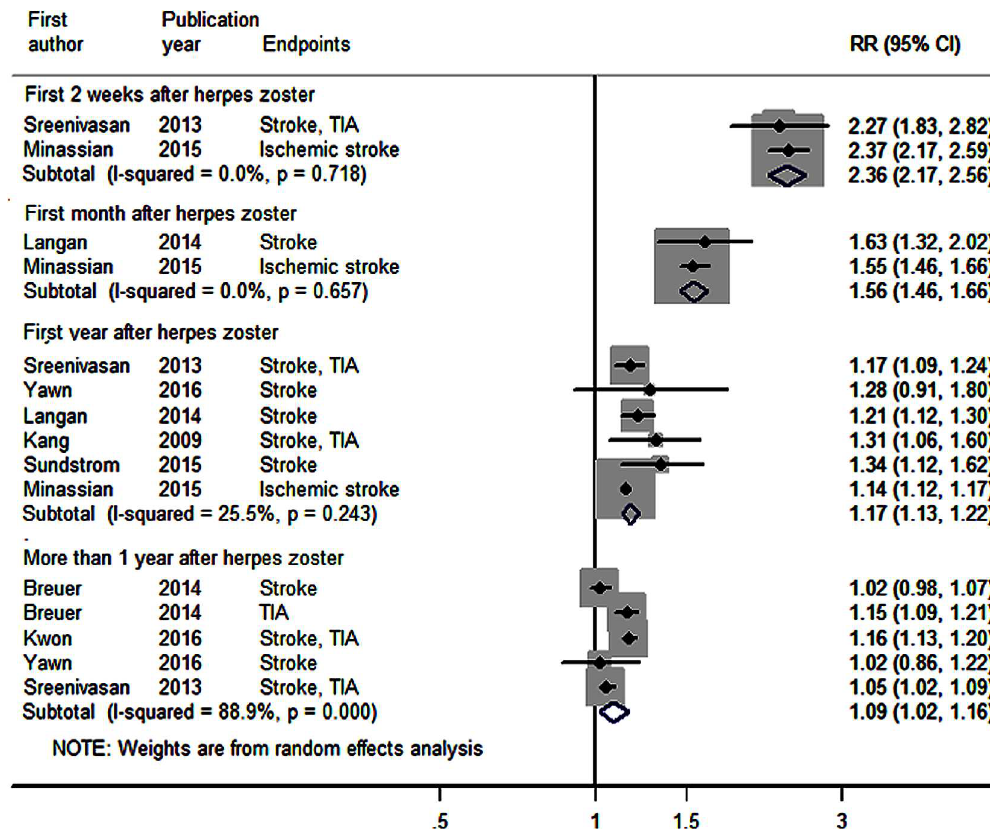
Fig 2. Forest plot of the association between herpes zoster and stroke. The figure shows meta-analysisof the stroke risks after herpes zoster for first 2 weeks, first month, first year, and more than 1 year, respectively. Diamondindicatesthe overall relative risks (RRs) for the analysis, width of the diamond represents the 95% confidence interval (CI), and boxes represent the weight of individualstudies in the pooledanalysis.